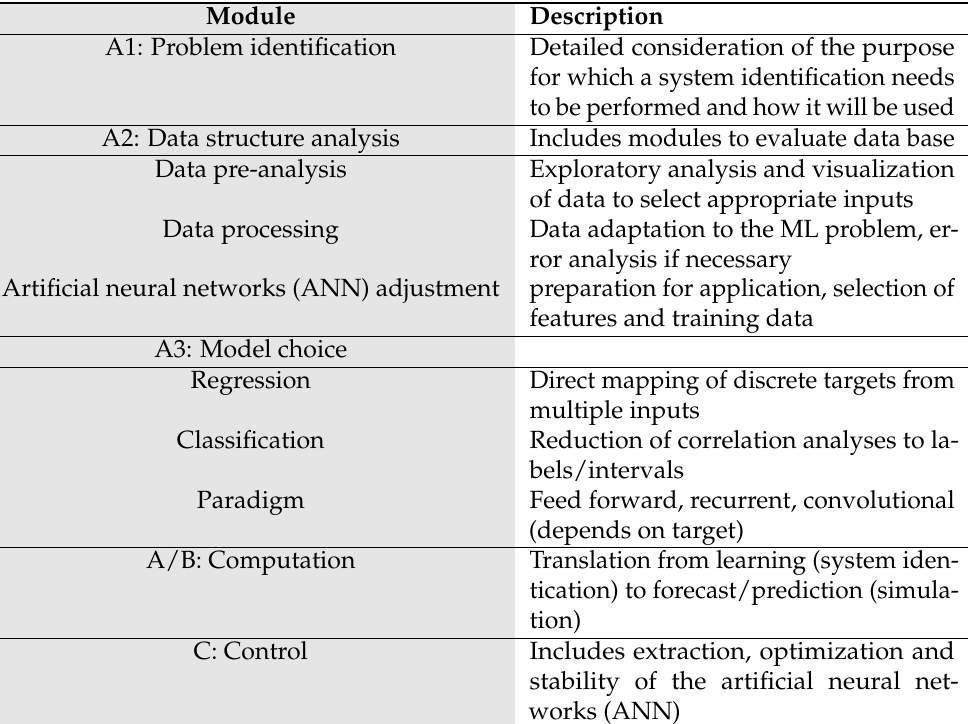
Table 4. Framework modules for system identification (A), simulation (B) and control (C).